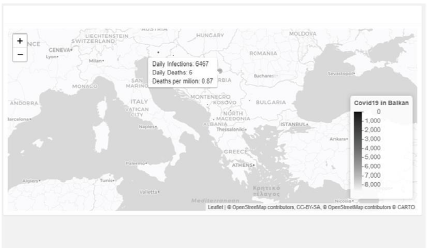
Figure 3: Dashboard map feature ofering information regarding COVID-19 metrics.